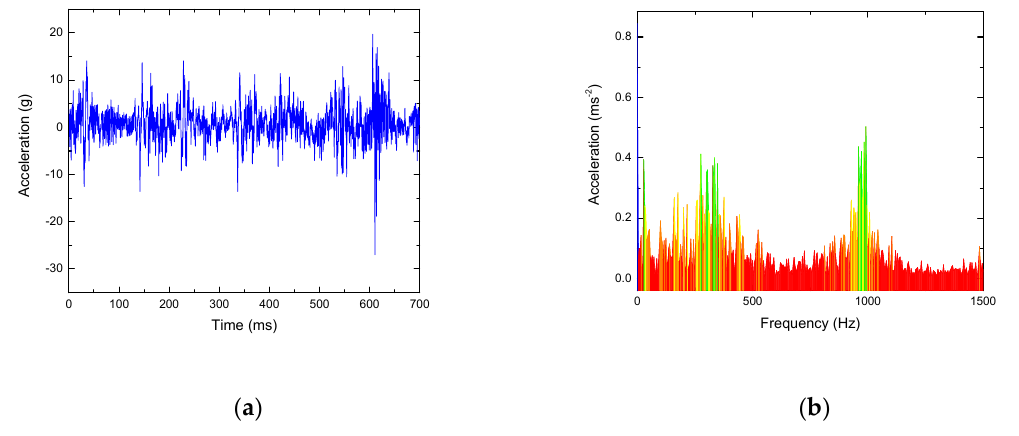
Figure 14. Spectrum analysis of a rail vibration signal with peeling damage. ( a ) Waveform; ( b ) frequency spectrum.